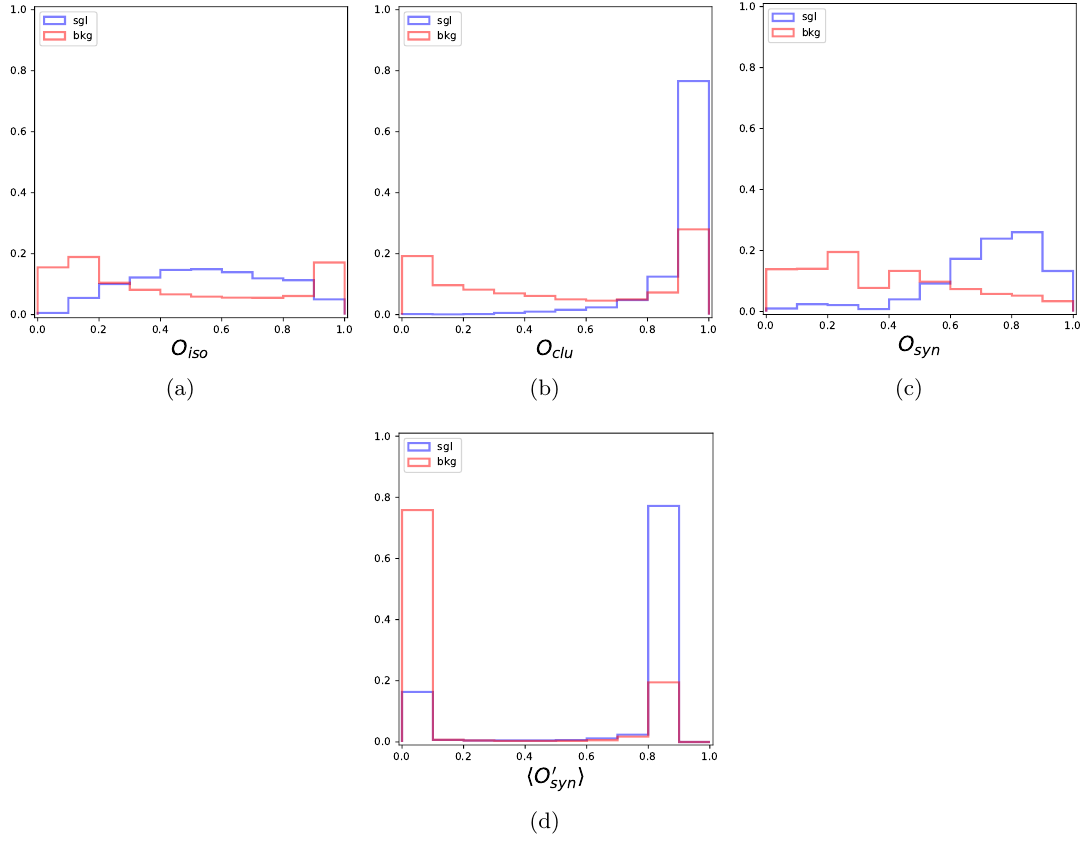
Figure 10 . Distribution of scores according to the different R AE -based novelty evaluators: (a) O iso , (b) O , (c) O and (d) h O 0 i , for the 2D Gaussian samples corresponding to BP 5. clu syn syn